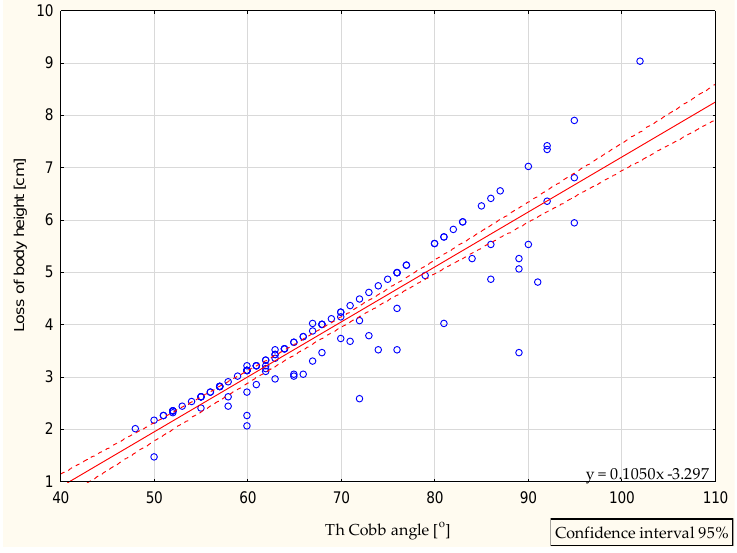
Figure 1. Thoracic Cobb angle magnitude versus loss of body height, Pearson’s correlation coefficient r = 0.93, p < 0.01, N = 120. 3.3. Predicted Pulmonary Parameters Calculated for the Measured versus the Corrected Body Height The predicted absolute value of FVC and FEV1, as well as the values of the LLN and ULN for each of the two pulmonary parameters (FVC and FEV1), were calculated accord- ing to the GLI 2012 reference values [17], using the measured body height and using the corrected body height, separately (Table 2), as well as within the Lenke types and the sub- groups (Appendix A). All the corresponding values — the predicted values of the FVC and FEV1, LLN and ULN calculated for the FVC and FEV1 — proved significantly different. Table 2. Predicted values of the pulmonary parameters calculated (GLI 2012, [17]) for the measured versus the corrected body height, N = 120. Parameter